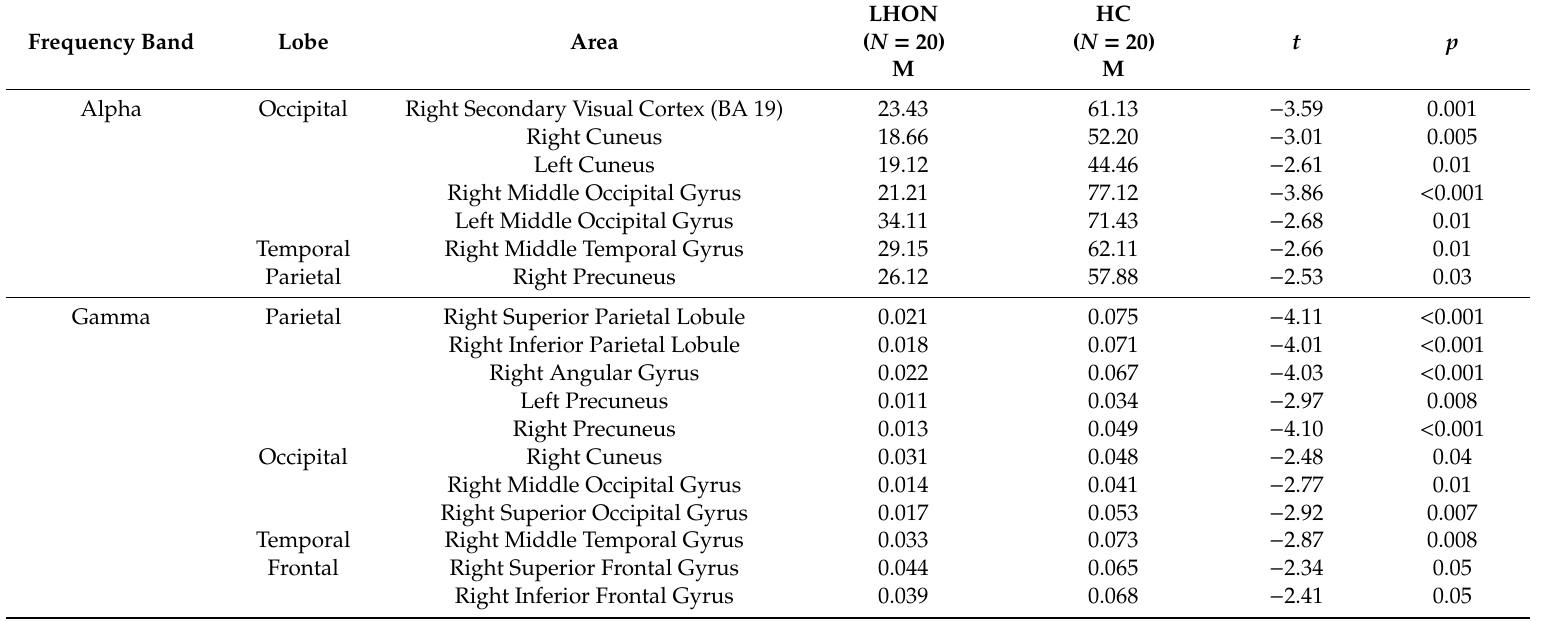
Table 2. Quantitative results of a between-group comparison regarding the current source density values in the alpha and gamma frequency bands that di ff erentiated the